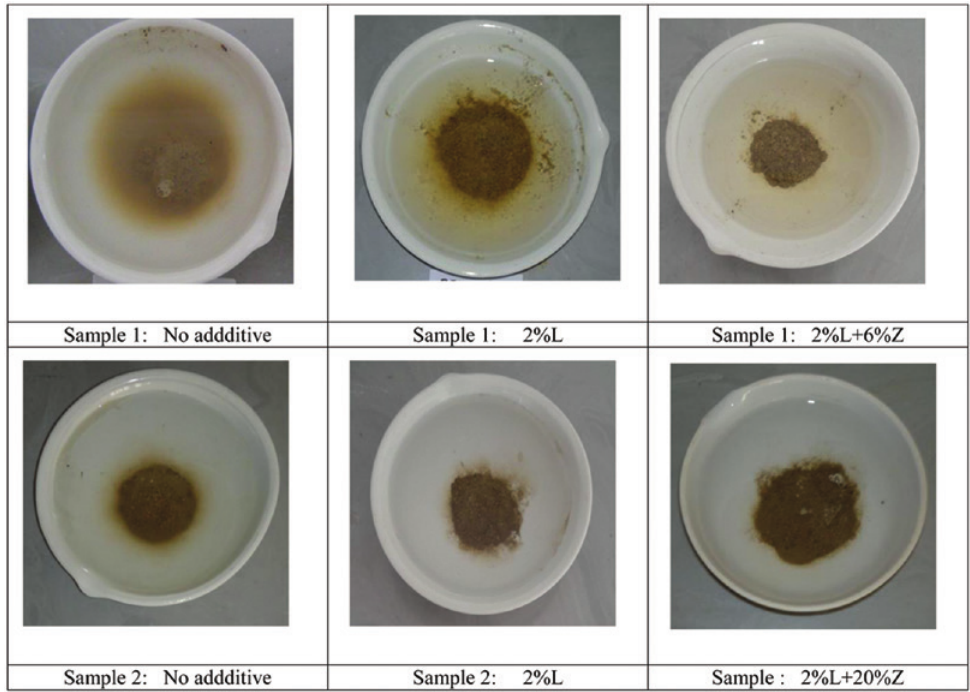
Figure 2: Crumb test results of the soil samples mixed with different additive